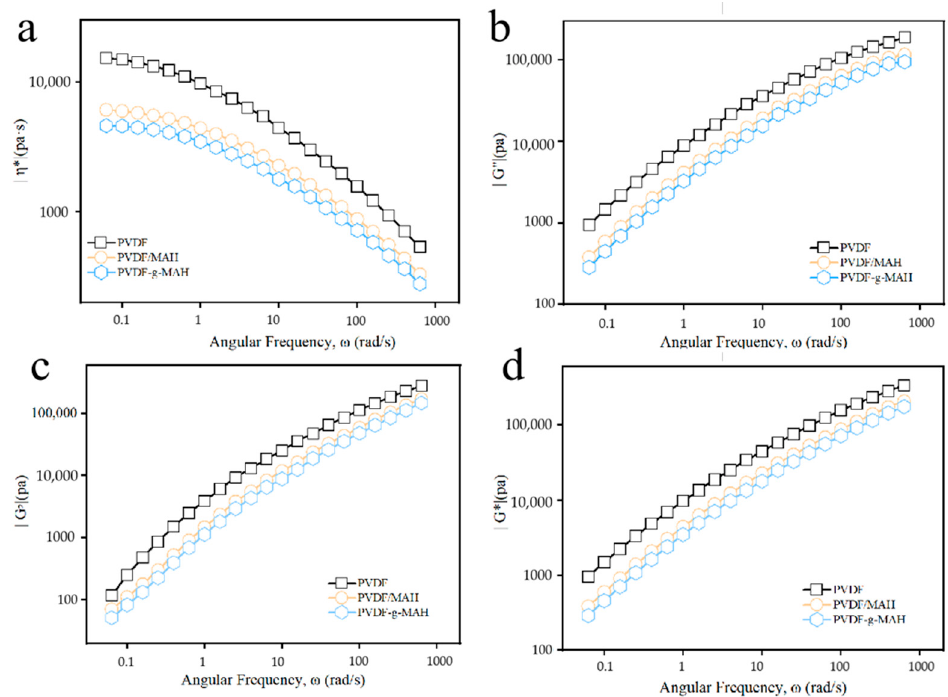
Figure 4. Rheological properties of PVDF, PVDF/MAH and PVDF-g-MAH (G = 0.63%): ( a ), viscosity; ( b ), viscosity modulus; ( c ), elasticity modulus; ( d ), compiex modulus.